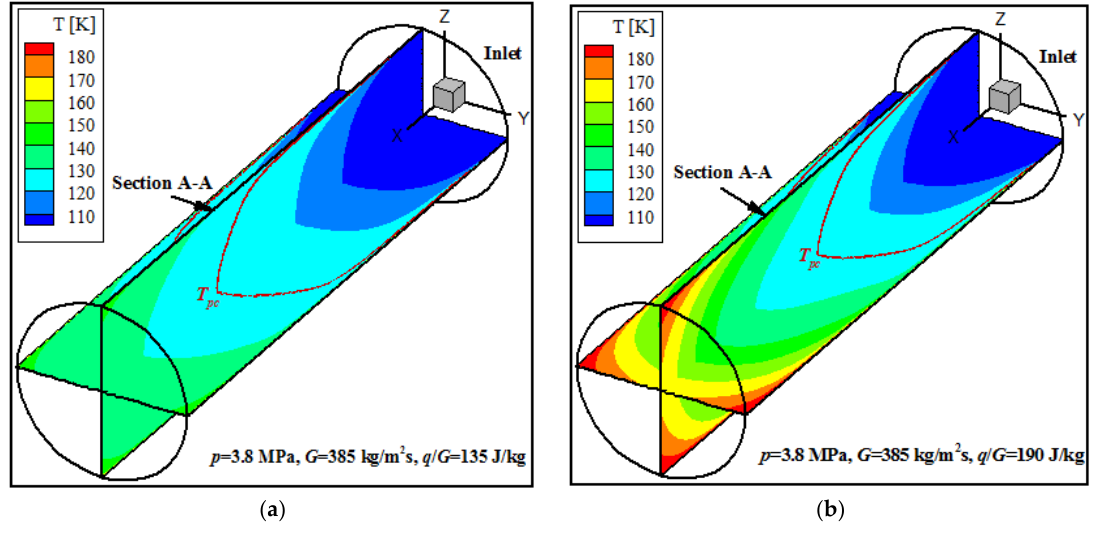
Figure 8. Temperature distributions within the test on the XZ and XY planes (X:Y:Z = 1:100:100) for the numerical cases at p = 3.8 MPa, G = 385 kg/m 2 · s, and T in = 101 K with different values of q / G : ( a ) q / G = 135; and ( b ) q / G = 190. The red line indicates the isothermal line of T pc